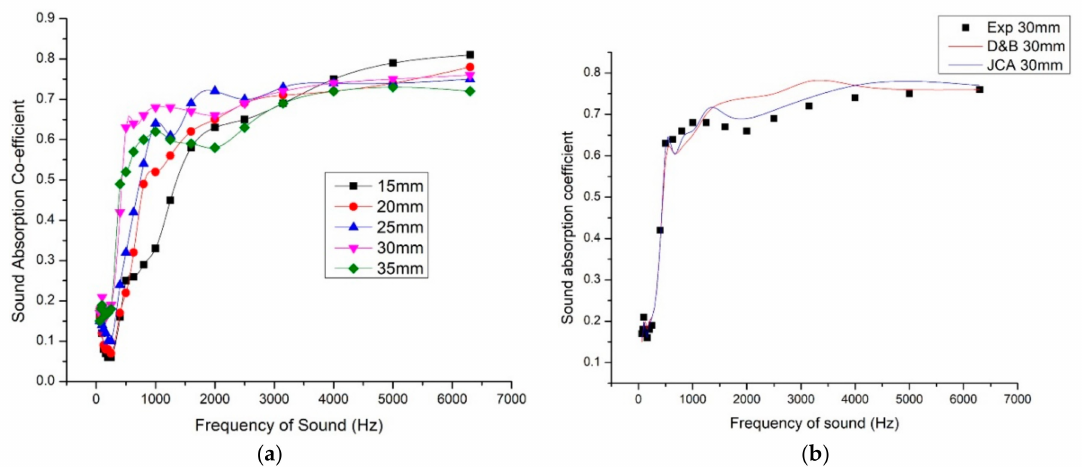
Figure 7. ( a ) Variation of sound absorption coe ffi cient with respect to thickness. ( b ) Comparison of experimental SAC values with the estimated SAC values using Delany and Bezley model (D&B) and